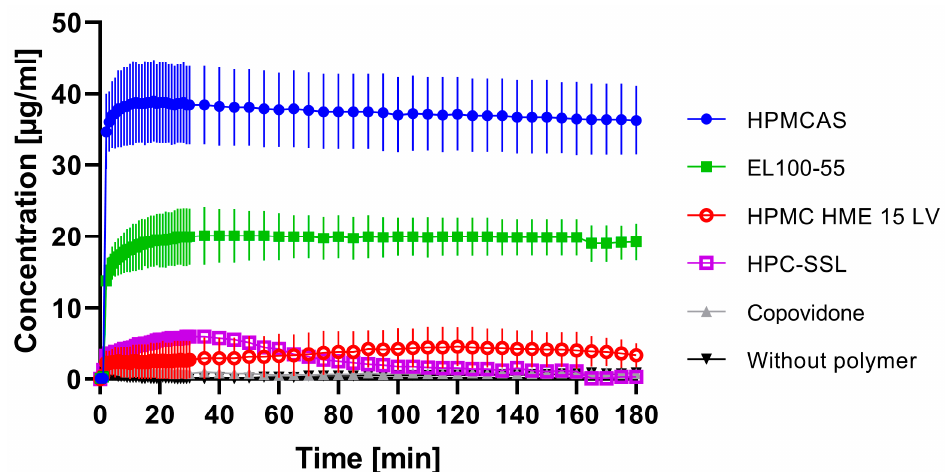
Figure 4. Supersaturation assay of 0.2 mg/mL ARCC-4 (=100%) in 20 mL 0.05 M phosphate buffer at pH 6.8 (37 ◦ C, 75 rpm paddle speed) dependent on pre-dissolved single polymers • HPMCAS, EL 100-55, HPMC HME 15 LV, HPC-SSL, ▲ Copovidone, and ▼ without polymer. For each experiment, the total polymer concentration was 1.25 mg/mL.